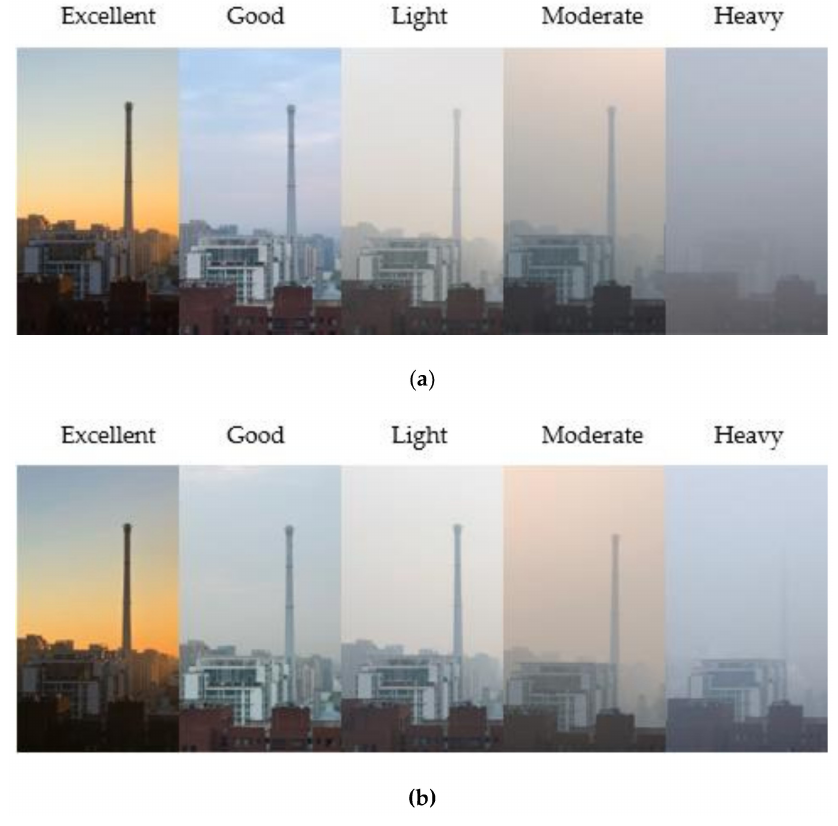
Figure 2. Reference images and target